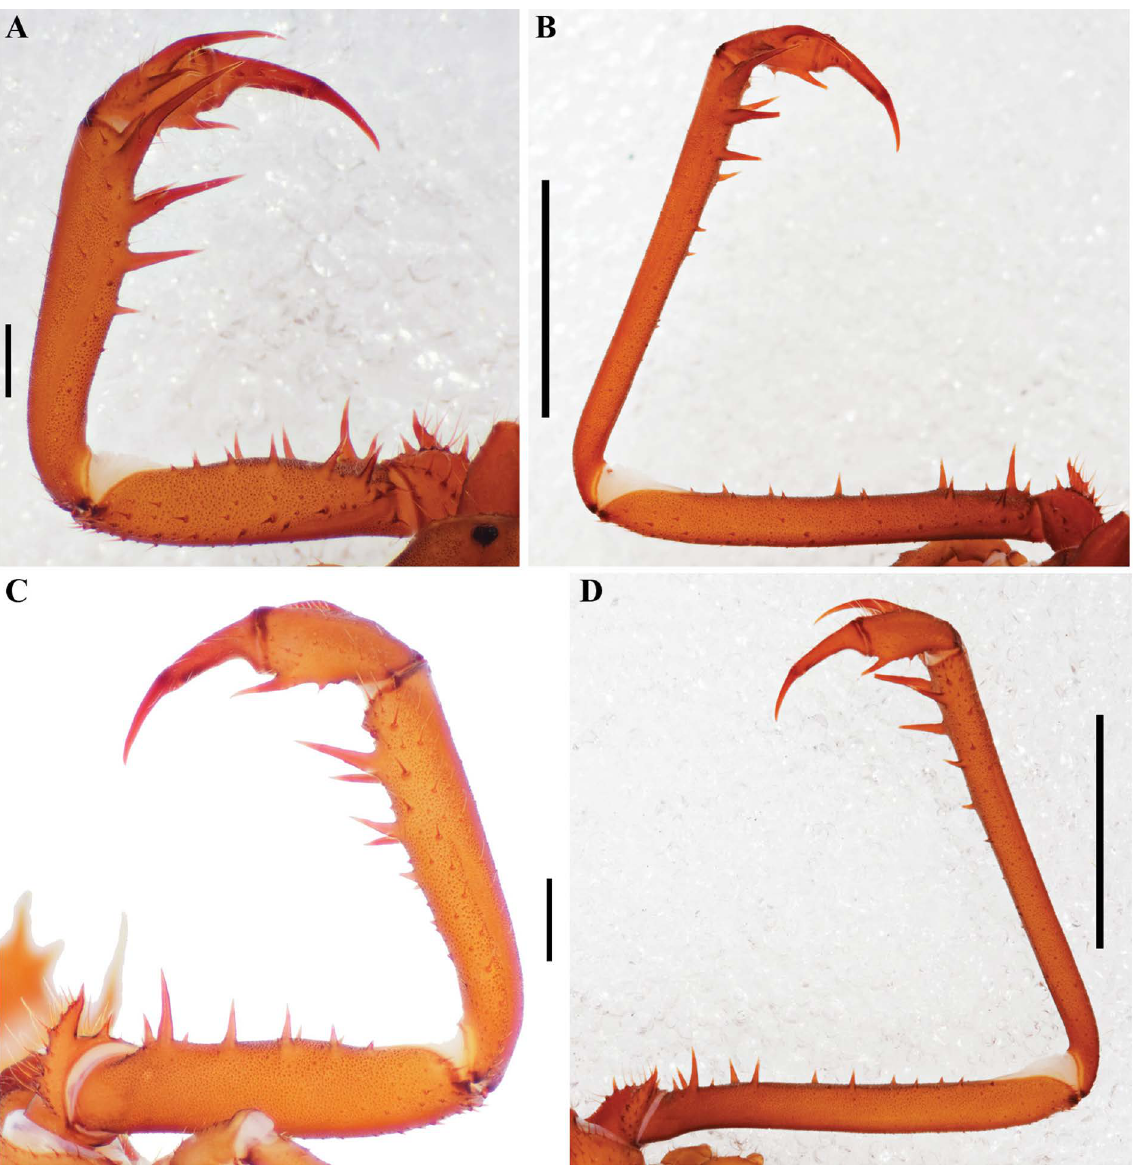
Fig. 62. Charinus euclidesi sp. nov. (MNRJ 9099), pedipalp. A . Female pedipalp, dorsal view. B . Male pedipalp, dorsal view. C . Female pedipalp, ventral view. D . Male pedipalp, ventral view. Scale bars: A, C = 1 mm; B, D = 0.5